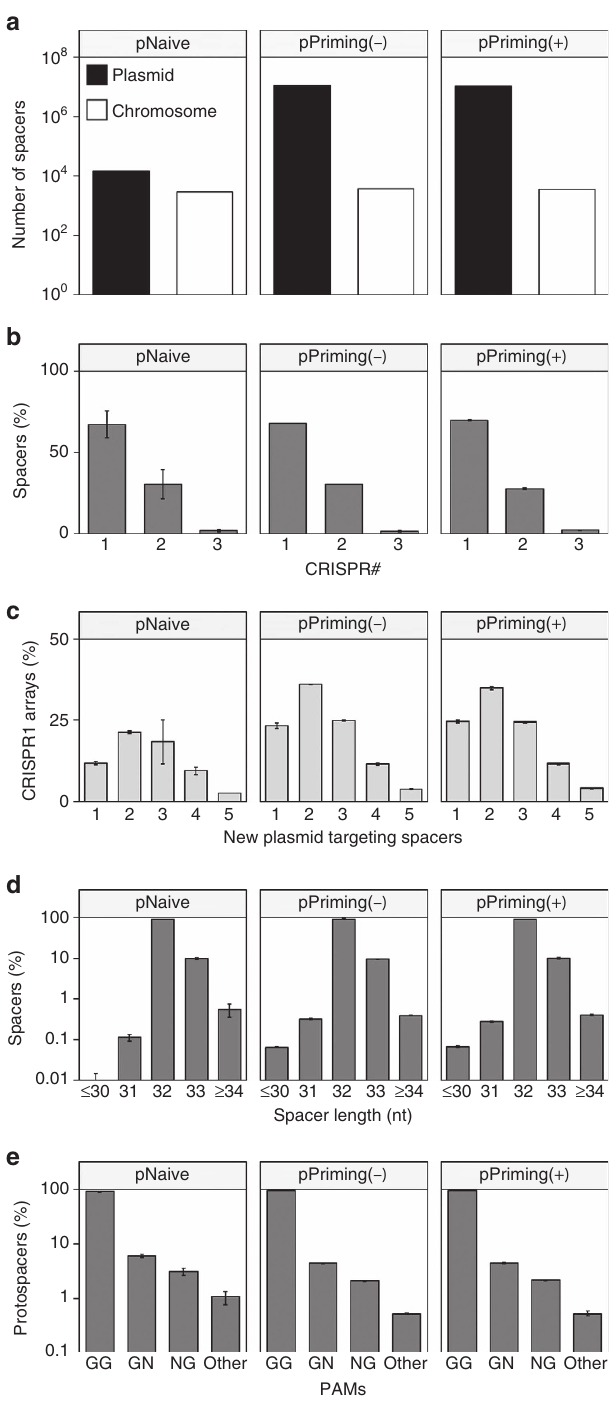
Figure 2 | Spacer and protospacer statistics. ( a ) Total number of spacers targeting the plasmid (black) or chromosome (white). ( b ) Proportion of spacers incorporated in CRISPR1, CRISPR2 or CRISPR3. ( c ) Frequency of the number of new plasmid-targeting spacers in CRISPR1. ( d ) Size distribution of new spacers. ( e ) Proportion of protospacers with a GG, GN, NG or other dinucleotide PAM sequence. Note that N stands for every nucleotide excluding G. Error bars represent the s.e. of the